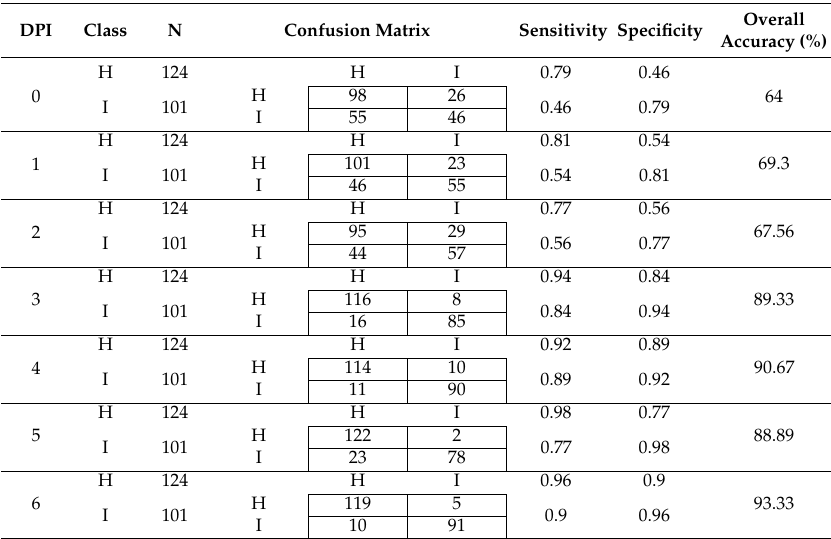
Table 7. Confusion matrix and related classification statistics when a Quadratic Support Vector Machine (SVM) classifier is applied to the reflectance at 668 1 , 705 2 , 717 3 and 740 4 nm to classify 124 healthy and 101 infected leaves as a function of the days post-inoculation (DPI).